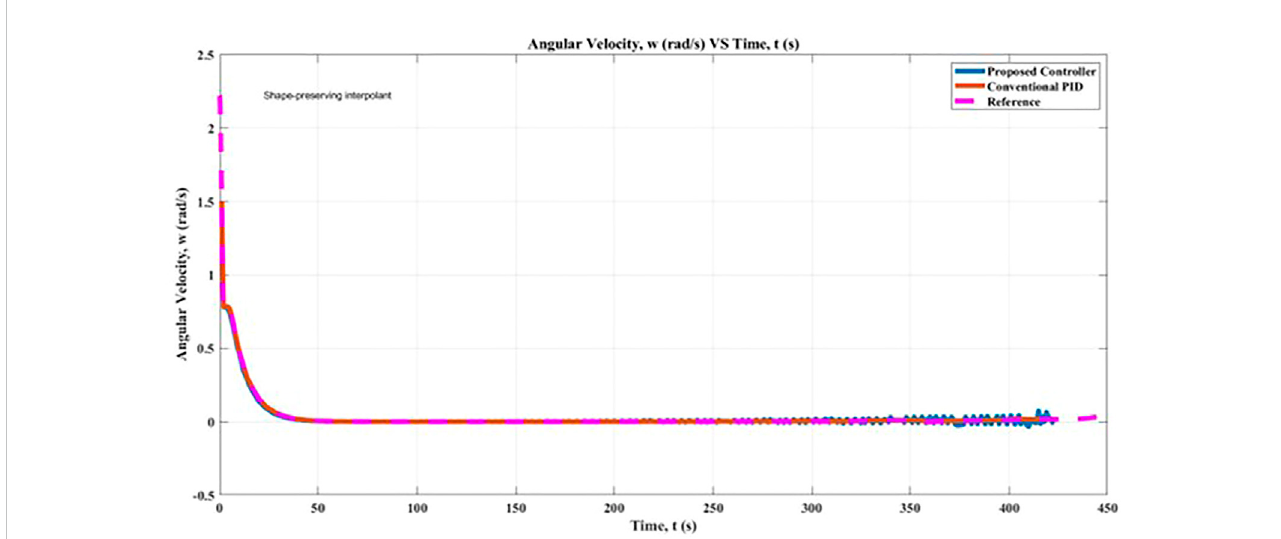
FIGURE 12 Angular Velocity, α comparison between proposed controller and conventional PID